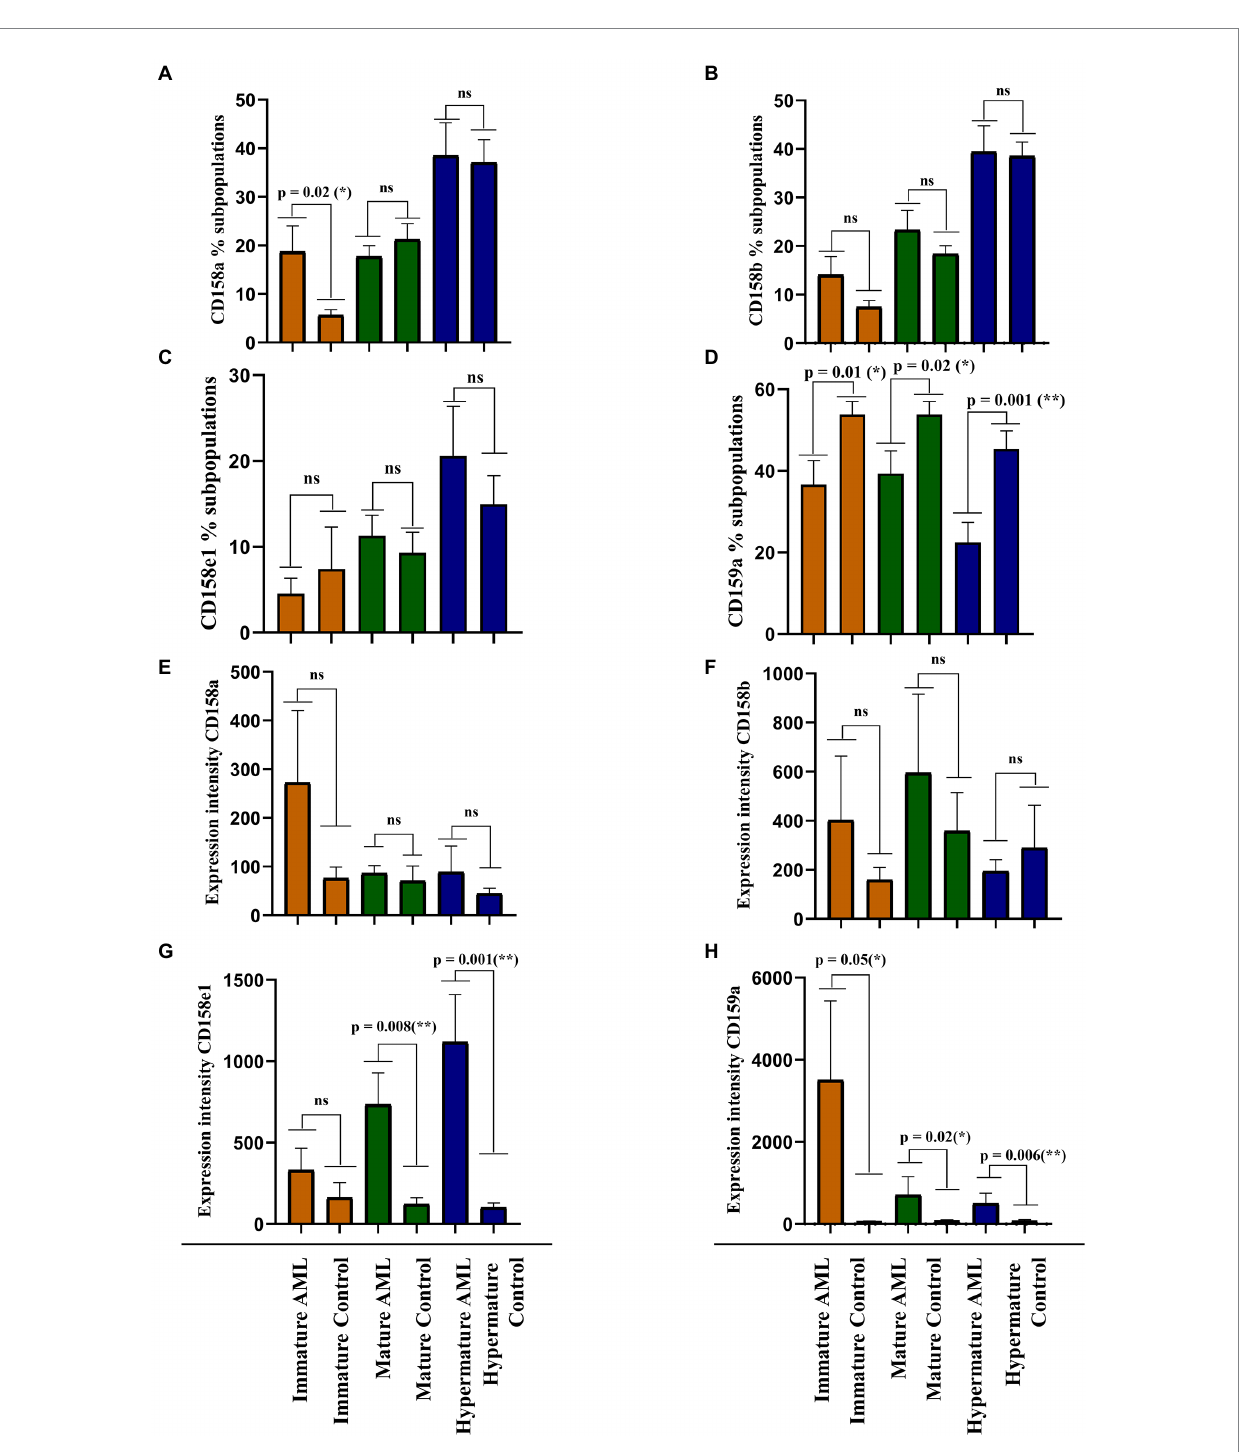
FIGURE 5 Comparison of cell percentages (A–D) and mean expression intensities (E–H) in distinct NK maturation subpopulations of AML ( n = 19) and healthy control ( n = 20) cases for each receptor. (A,E) CD158a; (B,F) CD158b; (C,G) CD158e1; (D,H) CD159a. Bars represent the mean ± SEM ( p < 0.01 (**), p < 0.05 (*), ns, not significant; two tailed unpaired t -test or Mann Whitney test were applied for the data with or without Gaussian distribution,